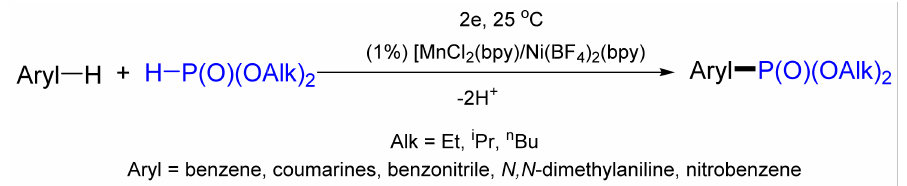
Figure 38. Phosphorylation of aromatic compounds in electrochemical